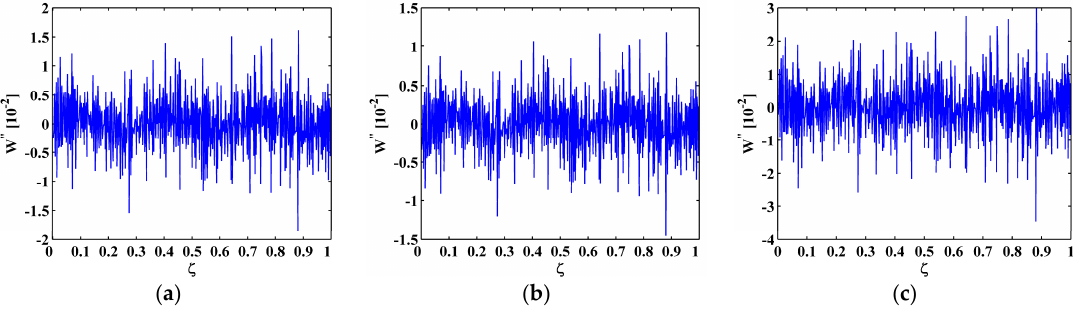
Figure 11. Modal curvatures for the ( a ) sixth; ( b ) seventh; and ( c ) eighth mode shapes with 45 dB SNR.